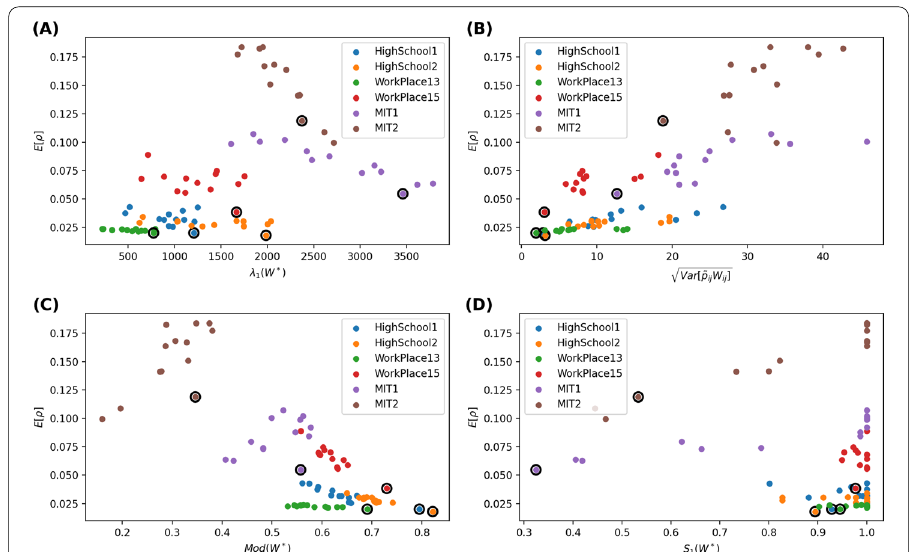
Fig. 3 Scatter plot of the average prevalence E [ ρ ] versus the largest eigenvalue (cid:31) 1 ( W ∗ ) of the aggregated pruned network ( A ), the standard deviation (cid:31) Var [˜ p ij w ij ] of the average number of contacts removed from a node pair ( B ) the modularity Mod ( W ∗ ) ( C ) and the relative size of the largest connected component of the aggregated pruned network ( D ), respectively. A fraction φ = 30% of the contacts are removed. The recovery rate is γ = 0 per step. The results obtained with 1/link weight strategy are